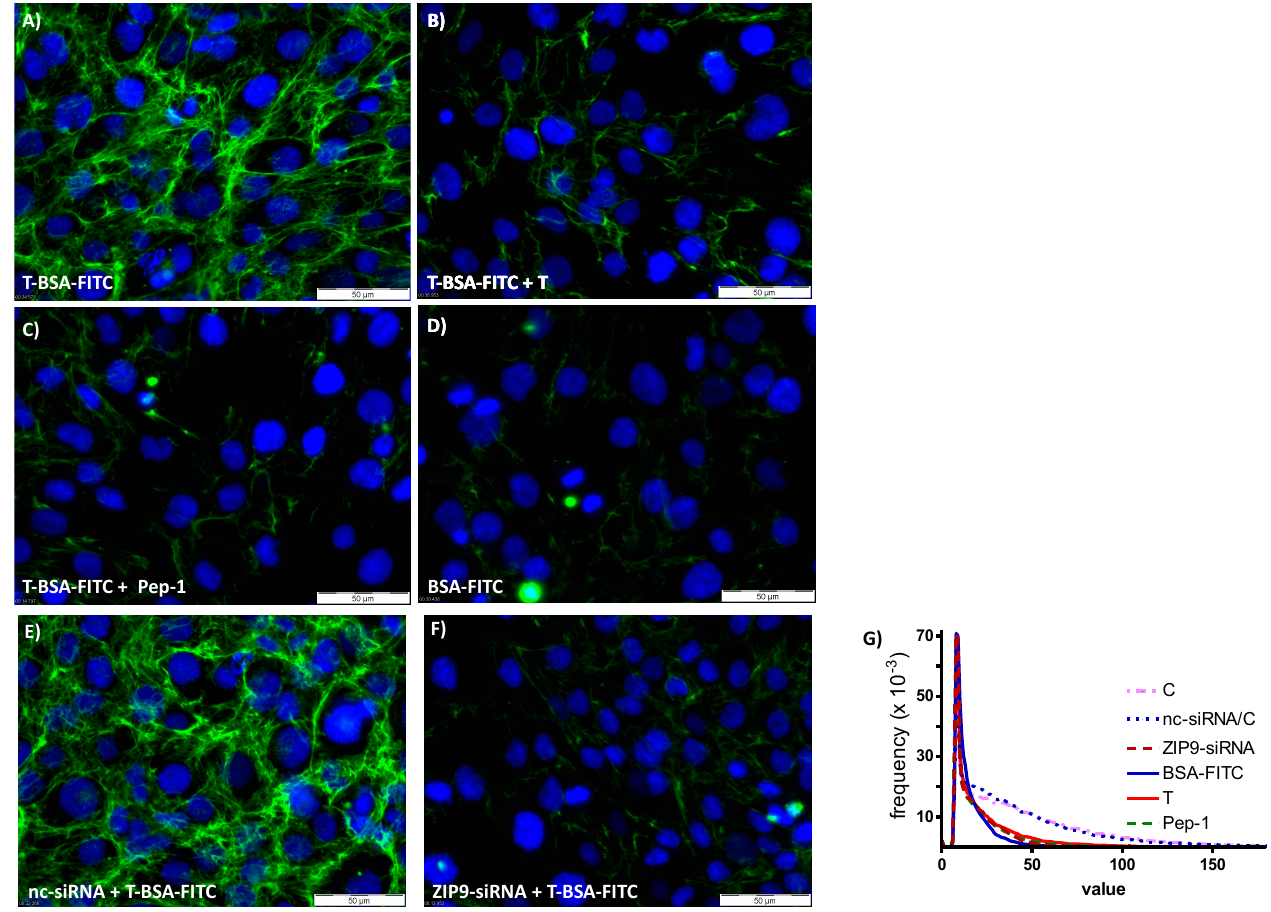
Figure 2. Displacement of T-BSA-FITC from the extracellular androgen binding site of L6 myoblasts by the synthesized peptides and testosterone. Nuclei are stained blue with DAPI; fluorescence corresponding to T-BSA-FITC is green. ( A ) When control cells are incubated with T-BSA-FITC, the compound labels their plasma membranes. ( B ) The simultaneous presence of testosterone (T) or ( C ) IAPG (Pep-1) greatly prevents labeling with T-BSA-FITC. The remaining labeling with green fluorescence does not differ significantly from the labeling obtained with BSA-FITC ( D ), indicating that it is due to non-specific interactions of either of the two compounds with some cellular components. ( E ) When cells that had been treated with negative control siRNA (nc-siRNA) are incubated with T-BSA-FITC, the testosterone analog labels their membranes as in untreated controls shown in ( A ). ( F ) Silencing ZIP9 expression by ZIP9-specific siRNA (ZIP9-siRNA) entirely prevents binding of T-BSA-FITC, indicating that in these cells no other membrane-bound protein capable of specifically binding testosterone exists besides ZIP9. ( G ) Plots of green fluorescence intensity versus frequency summarize and support the conclusions listed above; treatment with nc-siRNA does not affect the binding of T-BSA-FITC, since this and the curve obtained under control conditions are almost identical. It also shows that testosterone and Pep-1 reduce the frequency of strong fluorescent signals to about the same extent. Similar results are obtained with BSA-FITC or after silencing ZIP9 expression by siRNA.